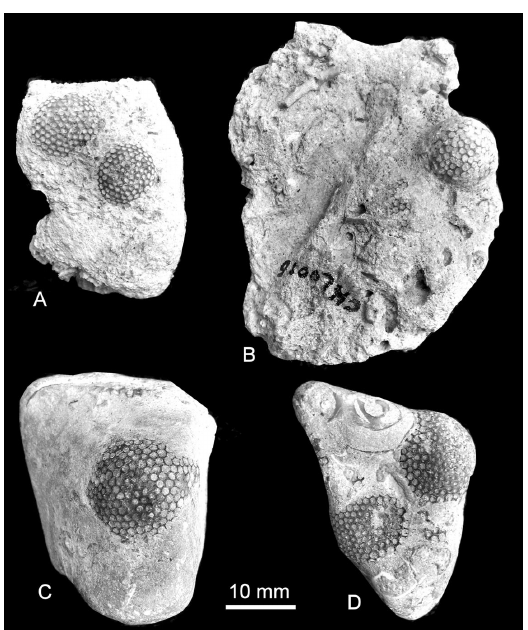
Fig. 17. A , B , fragments of hardgrounds (type 2C) showing massively silicified specimens of Coelosphaeridium sphaericum : A, RGM 1317652, Itterbeck; B, RGM 1317653, Itterbeck. C , D , similar fragments from Björkume, Gotland: C, PMU 31616; D, PMU 31617.